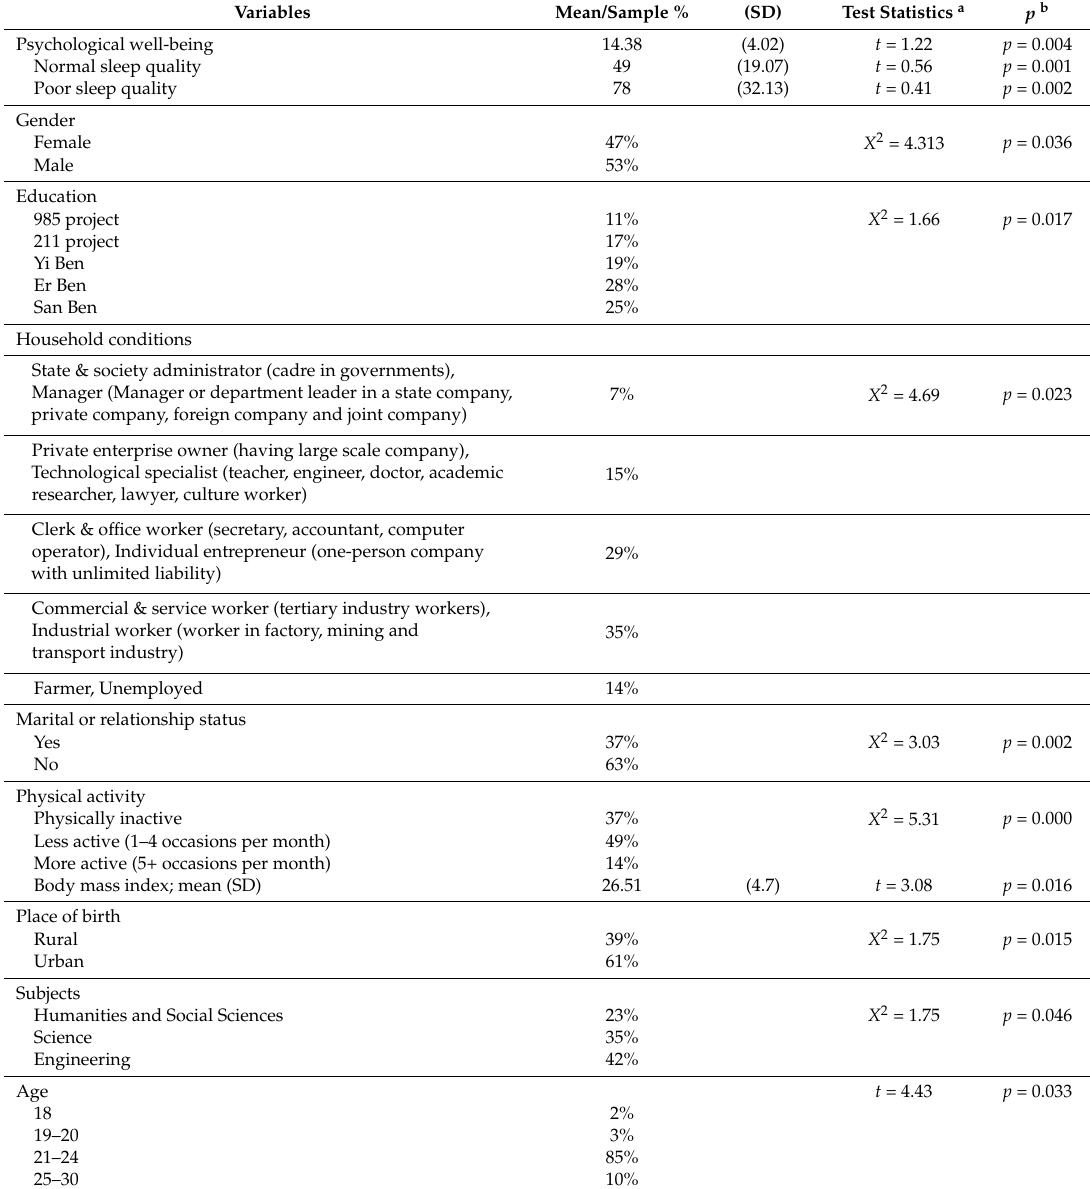
Table 1. Descriptive statistics ( N =